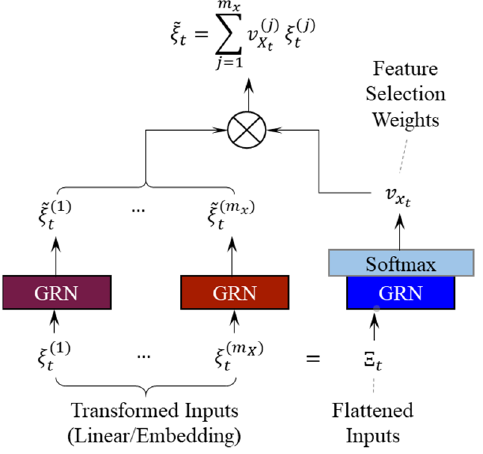
Figure 5. Illustration for feature selection network.